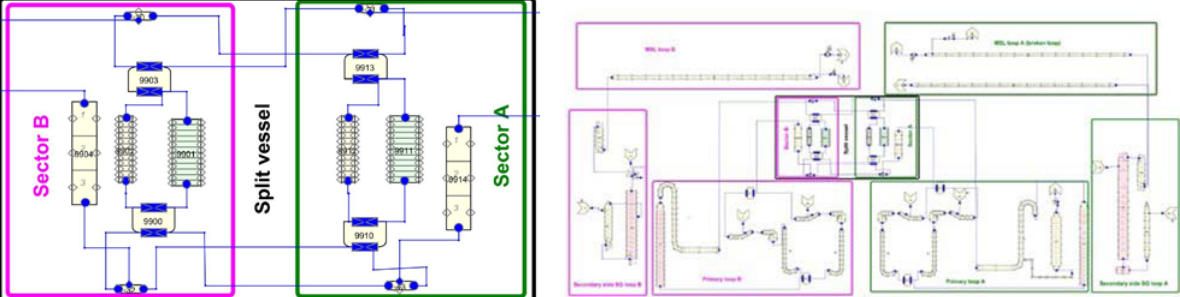
Figure 4. TRACE split-vessel model for OECD/NRC TMI MSLB